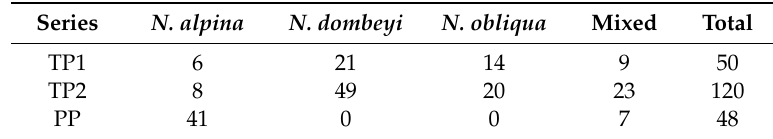
Table 2. Number of plots classified by dominant species (DOM-SP) for the Temporary Plot 1 (TP1), Temporary Plot 2 (TP2), and Permanent Plot (PP) series. N. = Nothofagus .